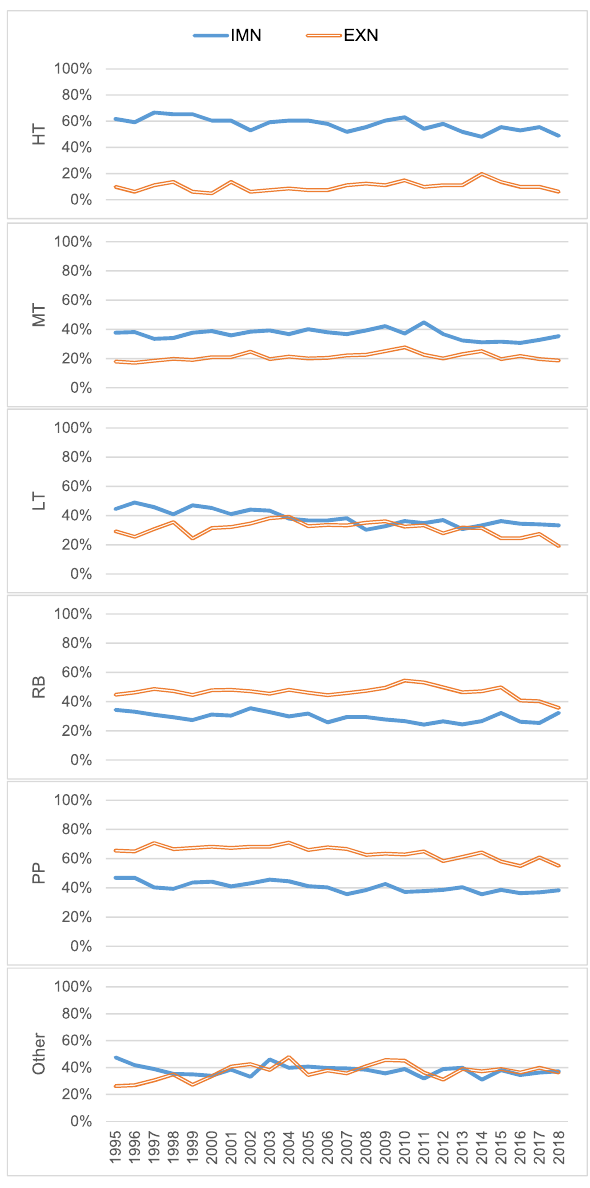
Figure 2. Development of the proportion of scale-free products in IMN (blue) and EXN (orange) from 1995 to